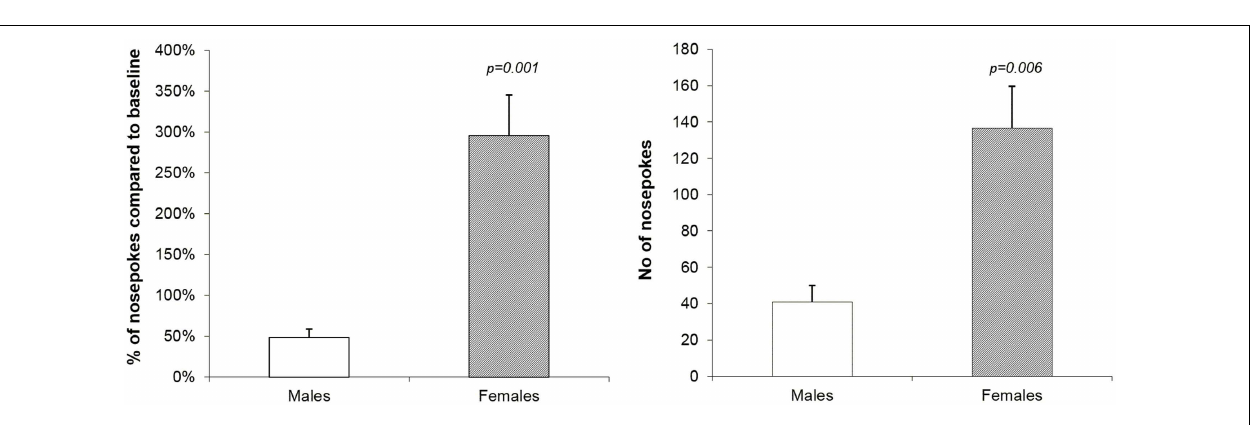
male rats showed mean % of responding 48.3% and females 295.7% (mixed ANOVA model, p = 0.001). The apparent difference between the sexes is further confirmed by behavioral activity reflected in a mean number of nose-pokes: 41.0 in males and 136.5 in females (mixed ANOVA model, p =